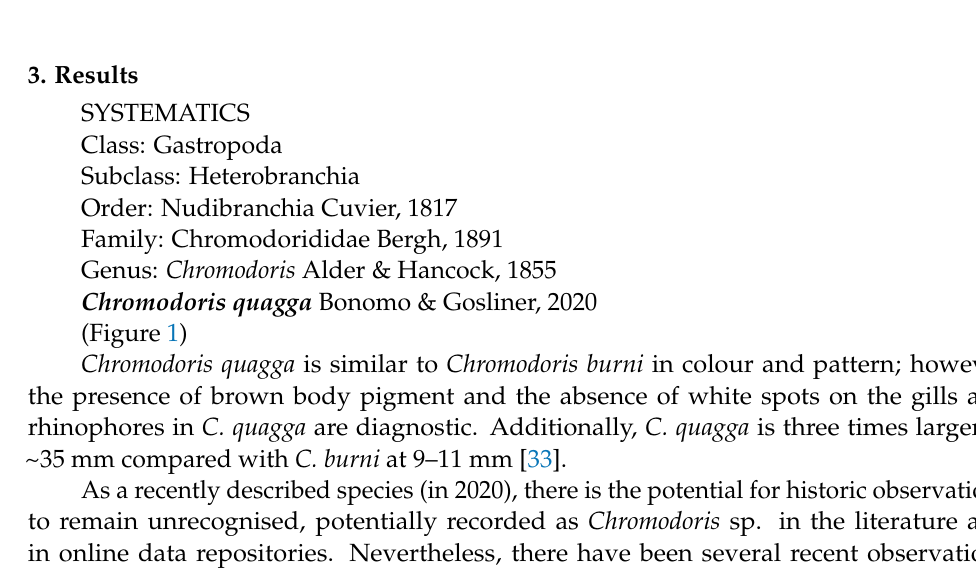
Table 1. Distribution records of Chromodoris quagga in Oceania.